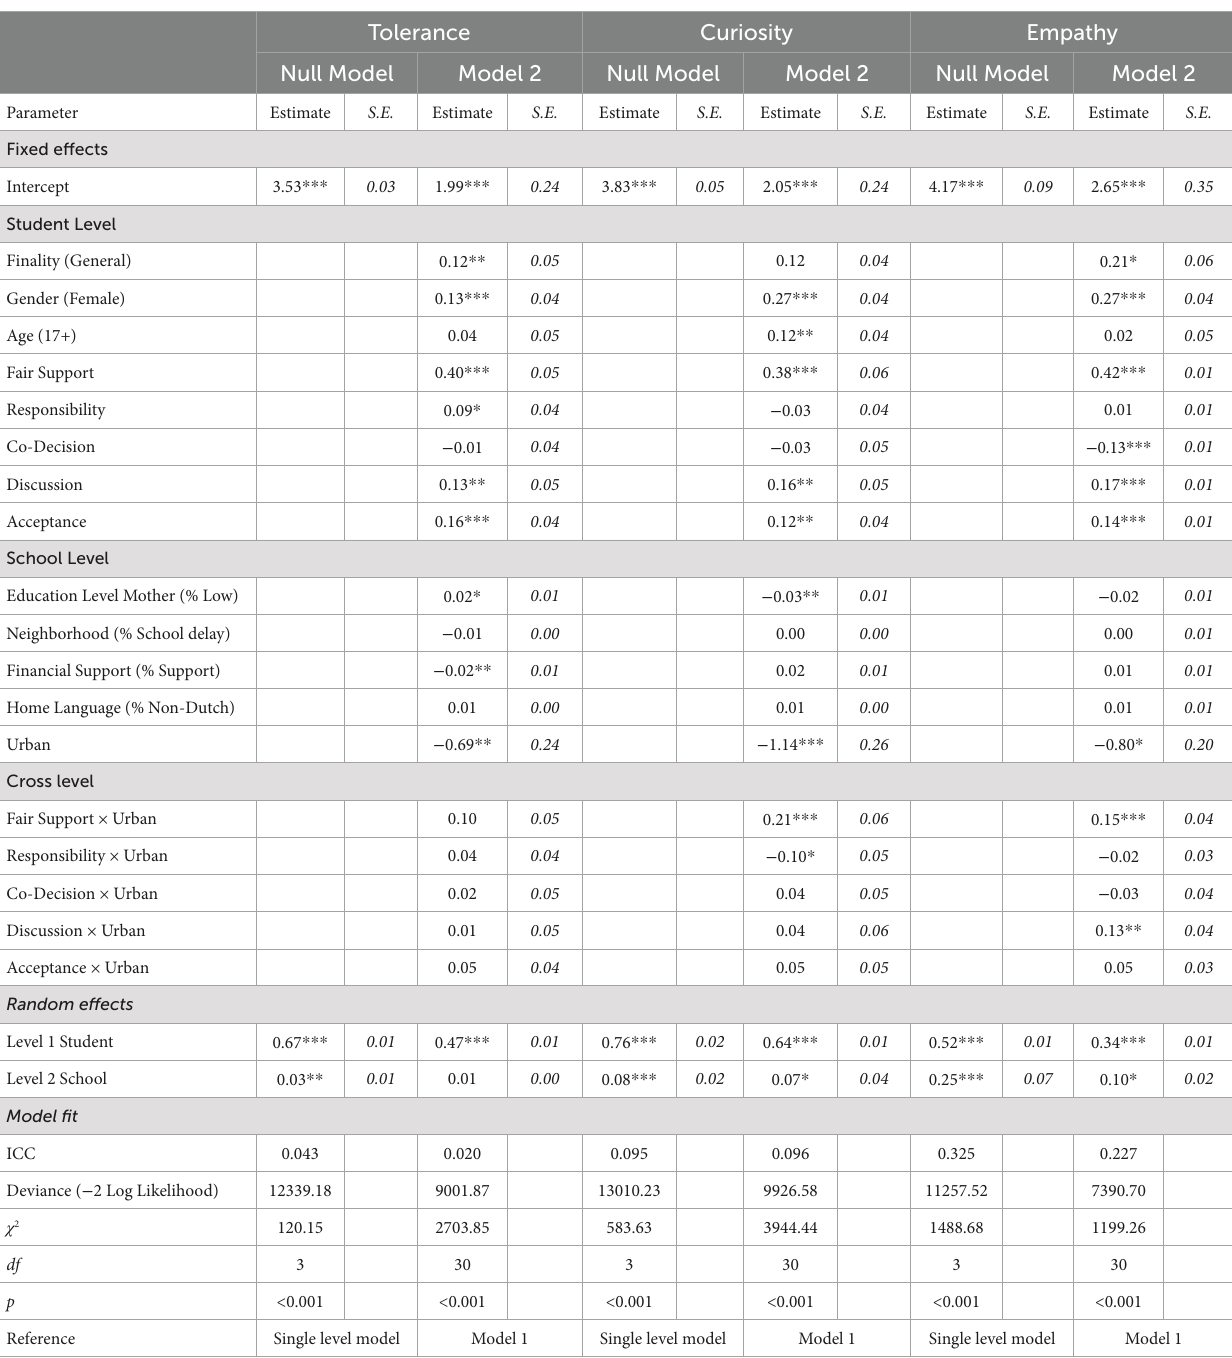
TABLE 4 Multilevel results of three deliberative